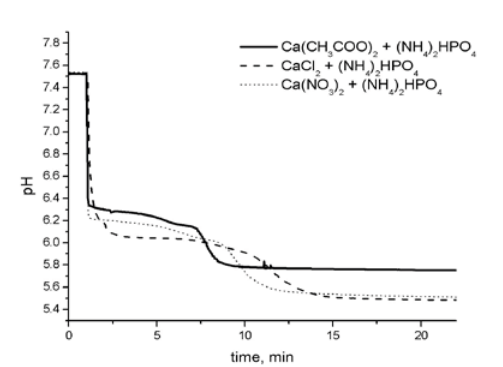
Figure 3. Variation of pH during precipitation of calcium phosphates. Figure 4. TG for powders synthesized from (NH